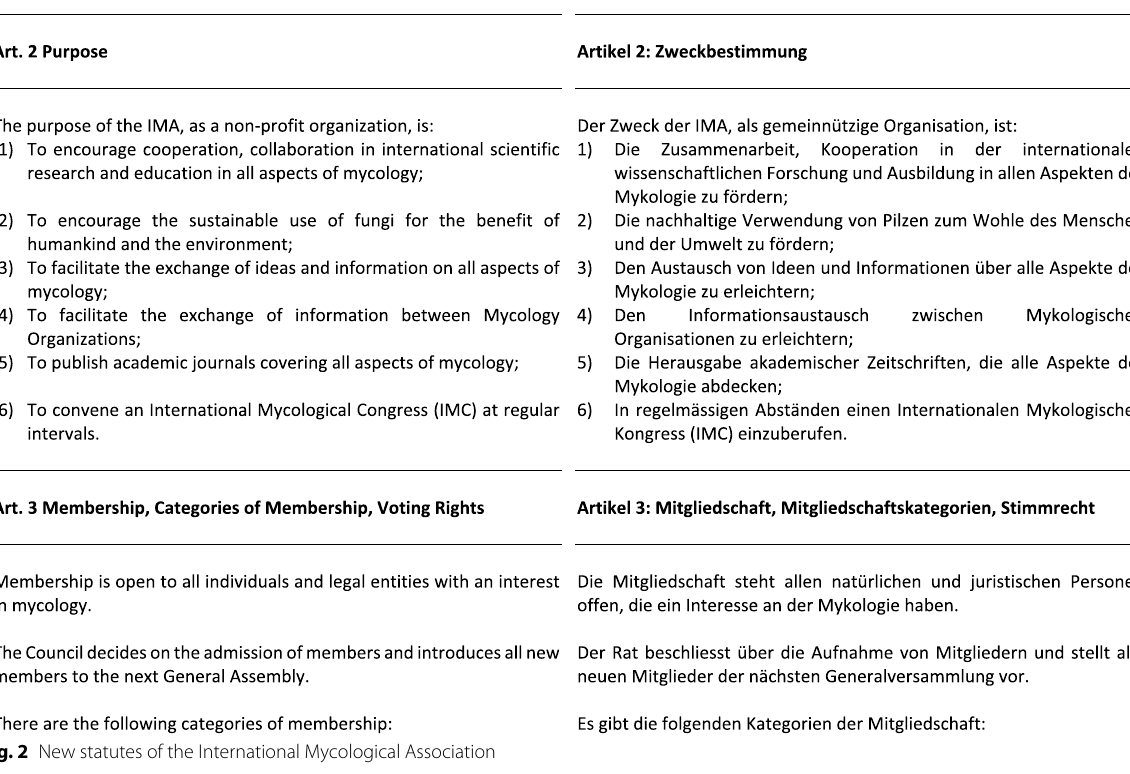
Fig. 2 New statutes of the International Mycological